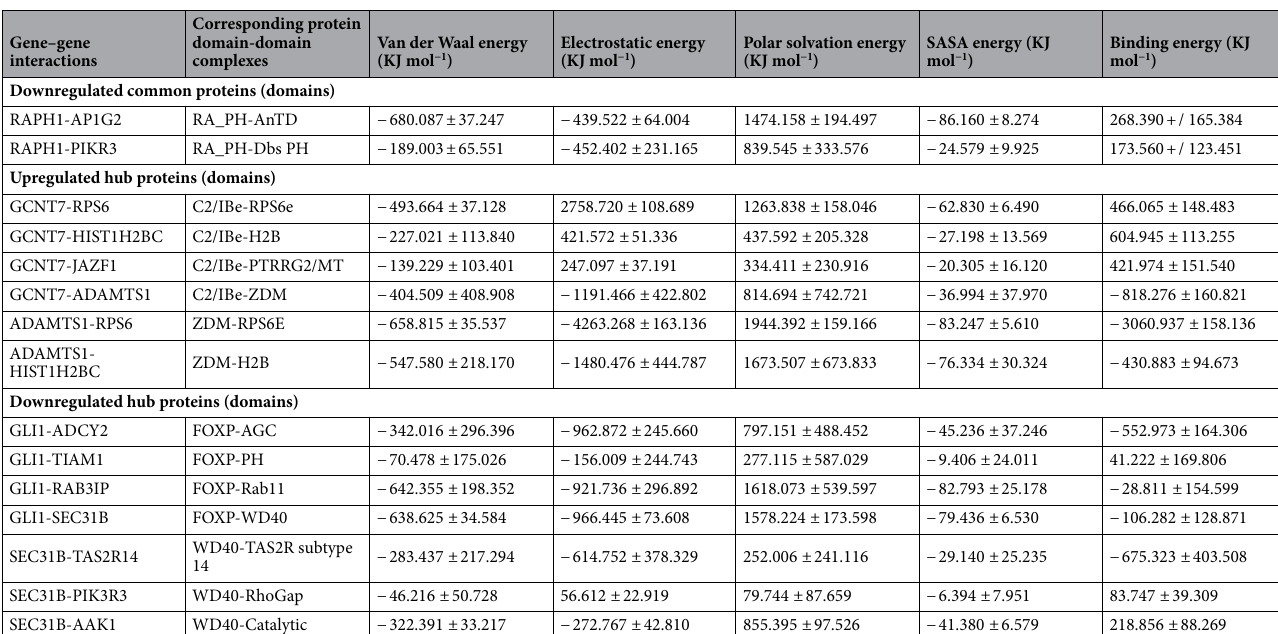
Table 4. MM/PBSA calculations of binding energy for the 14 protein complexes associated with the 5 significant drug